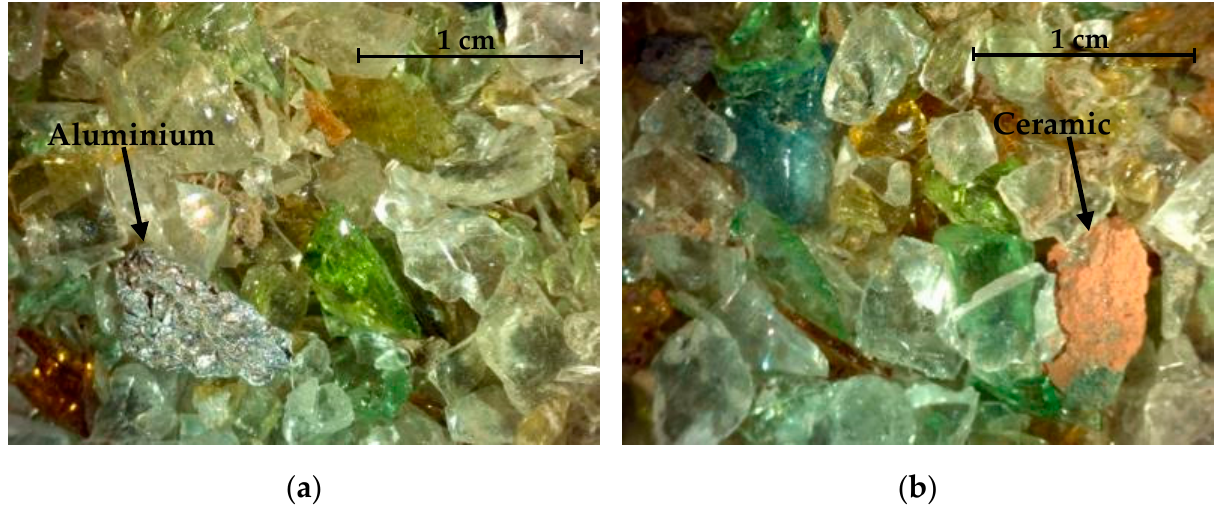
Figure 1. Magnified images of a WGR sample showing the presence of ( a ) aluminum and ( b ) ceramic particles in parallel with glass particles.